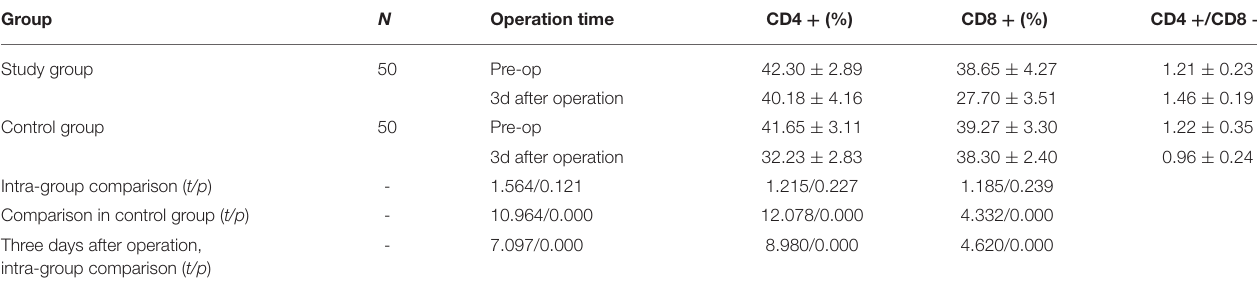
TABLE 4 | Comparison of T cell in the two groups ( ¯ X ± s).